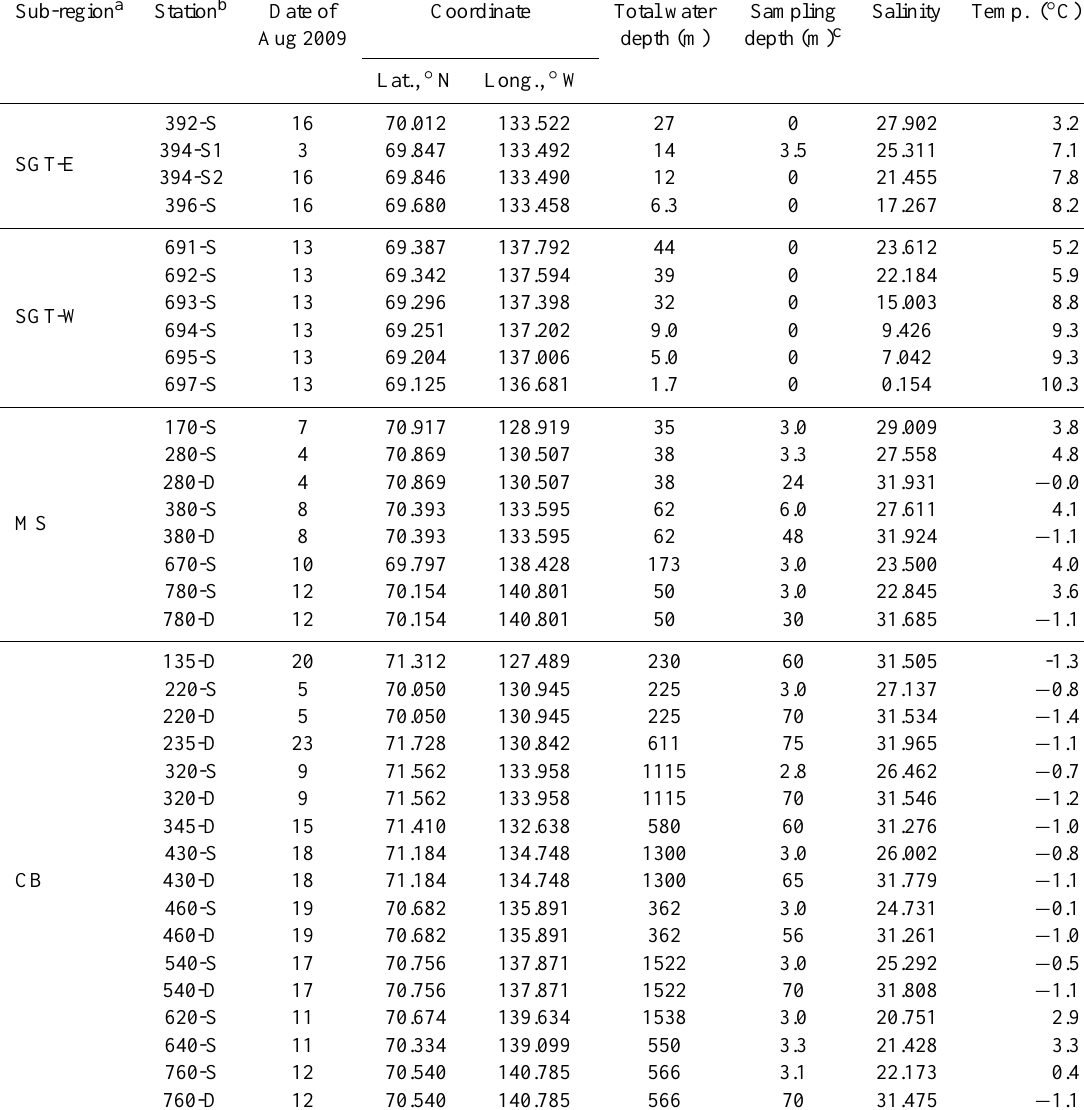
Table 1. Sampling information along with salinity and water